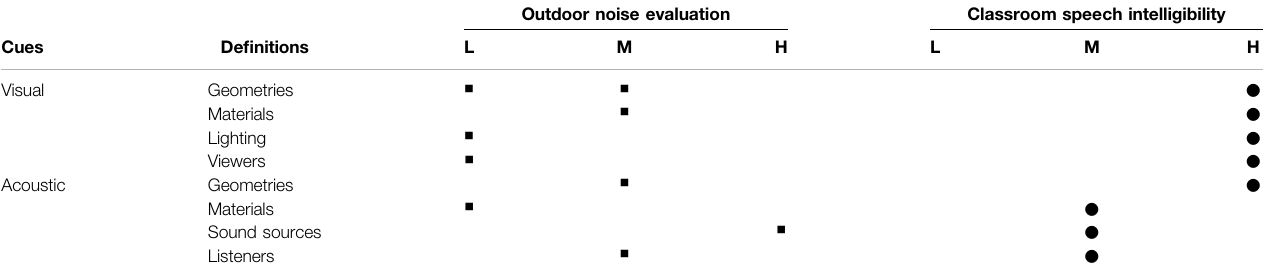
TABLE 2 | Suggested module combinations for demonstrators (A) outdoor noise evaluation and (B) classroom speech intelligibility.